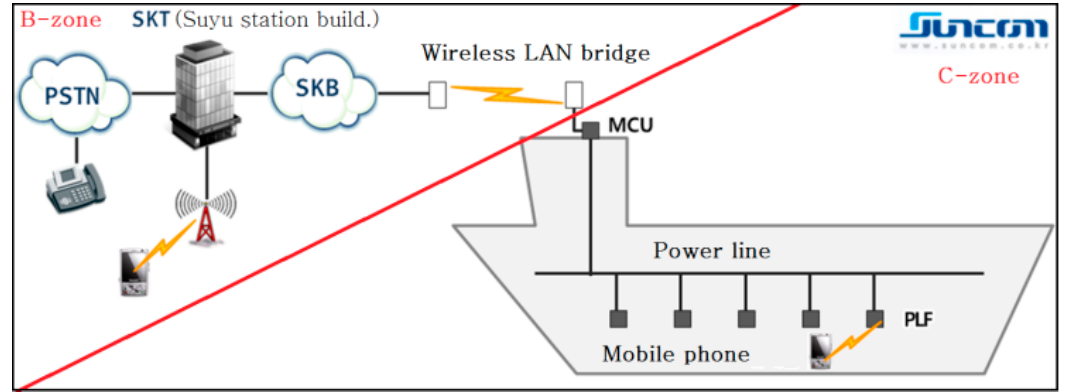
Figure 6. Configuration of the entire network.